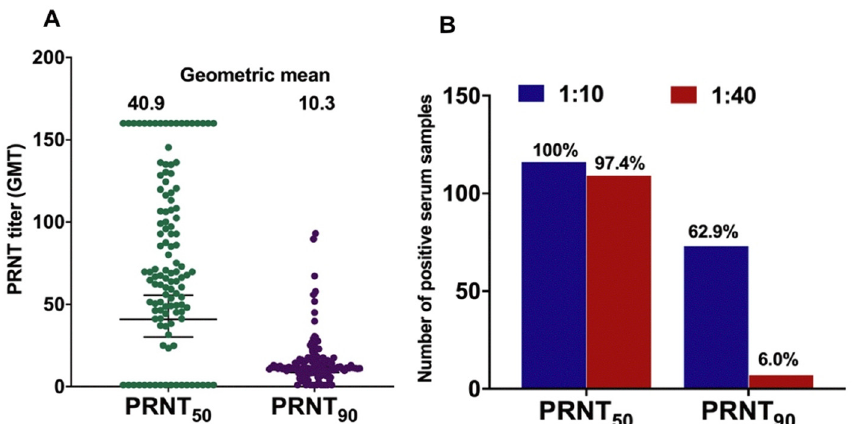
Figure 5. Geometric mean titer (GMT) of ZIKV neutralizing antibody (NAb) and the distribution of ZIKV NAb-positive sera at different thresholds ( n = 116). ( A ) GMT of ZIKV NAb using two thresholds (PRNT 50 and PRNT 90 ). ( B ) ZIKV seropositive sera were classified using a combination of four cut-offs (two thresholds of plaque reductions percentage and two cut-offs for serum dilutions).